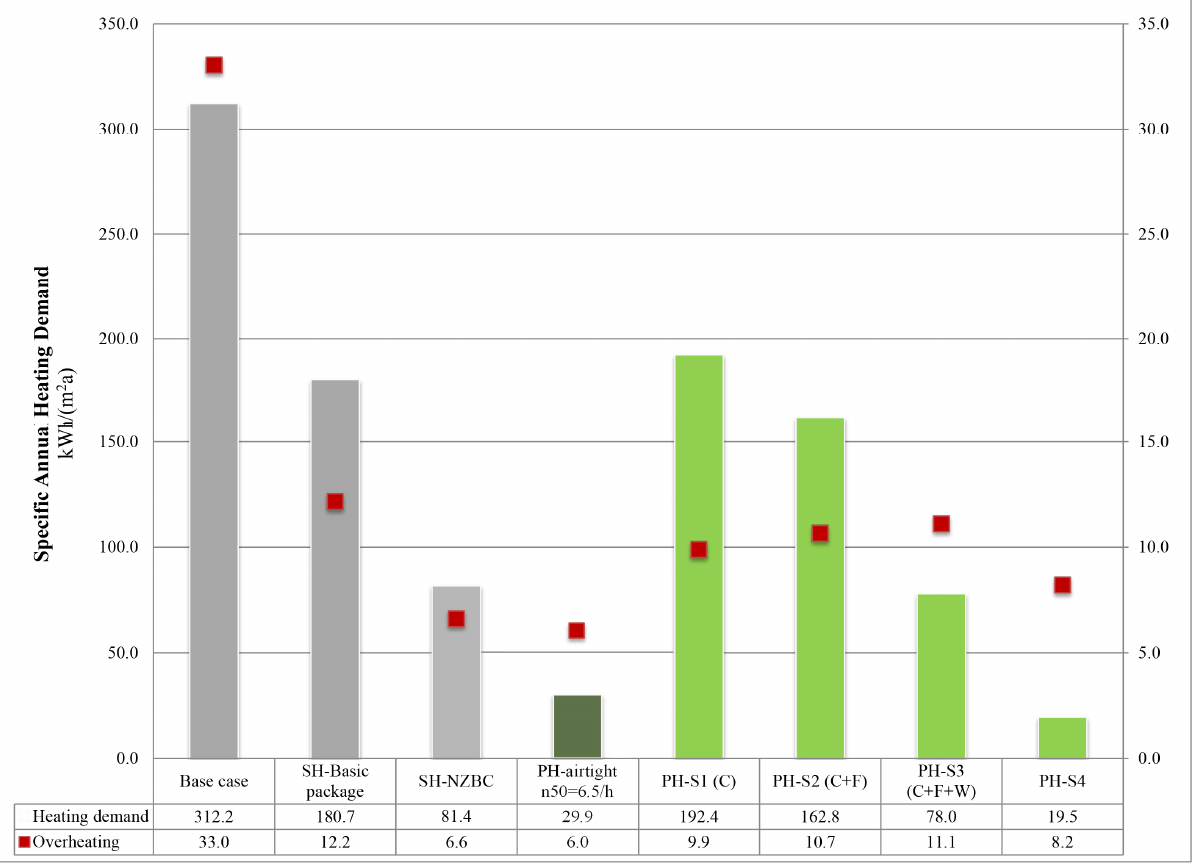
Figure 5. Comparison of specific annual heating demands (kWh/(m 2 a)) and overheating time (%) of the base case and different retrofitting